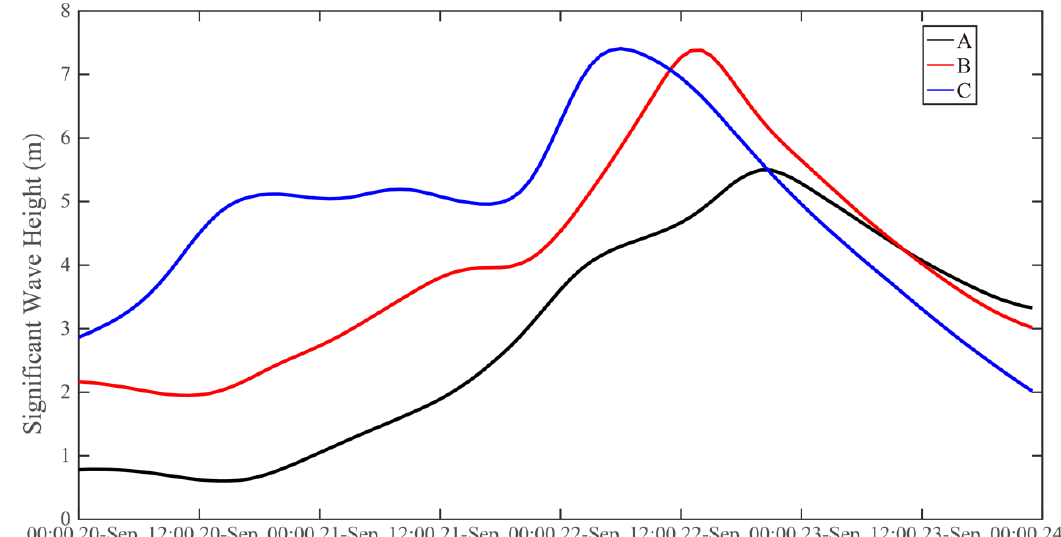
Figure 15. The average SWH maps simulated by the SWAN model when Typhoon Fung-wong passed the Zhoushan Islands on (a) 20 September 2014, (b) 21 September 2014, (c) 23 September 2014, and (d) 23 September 2014.